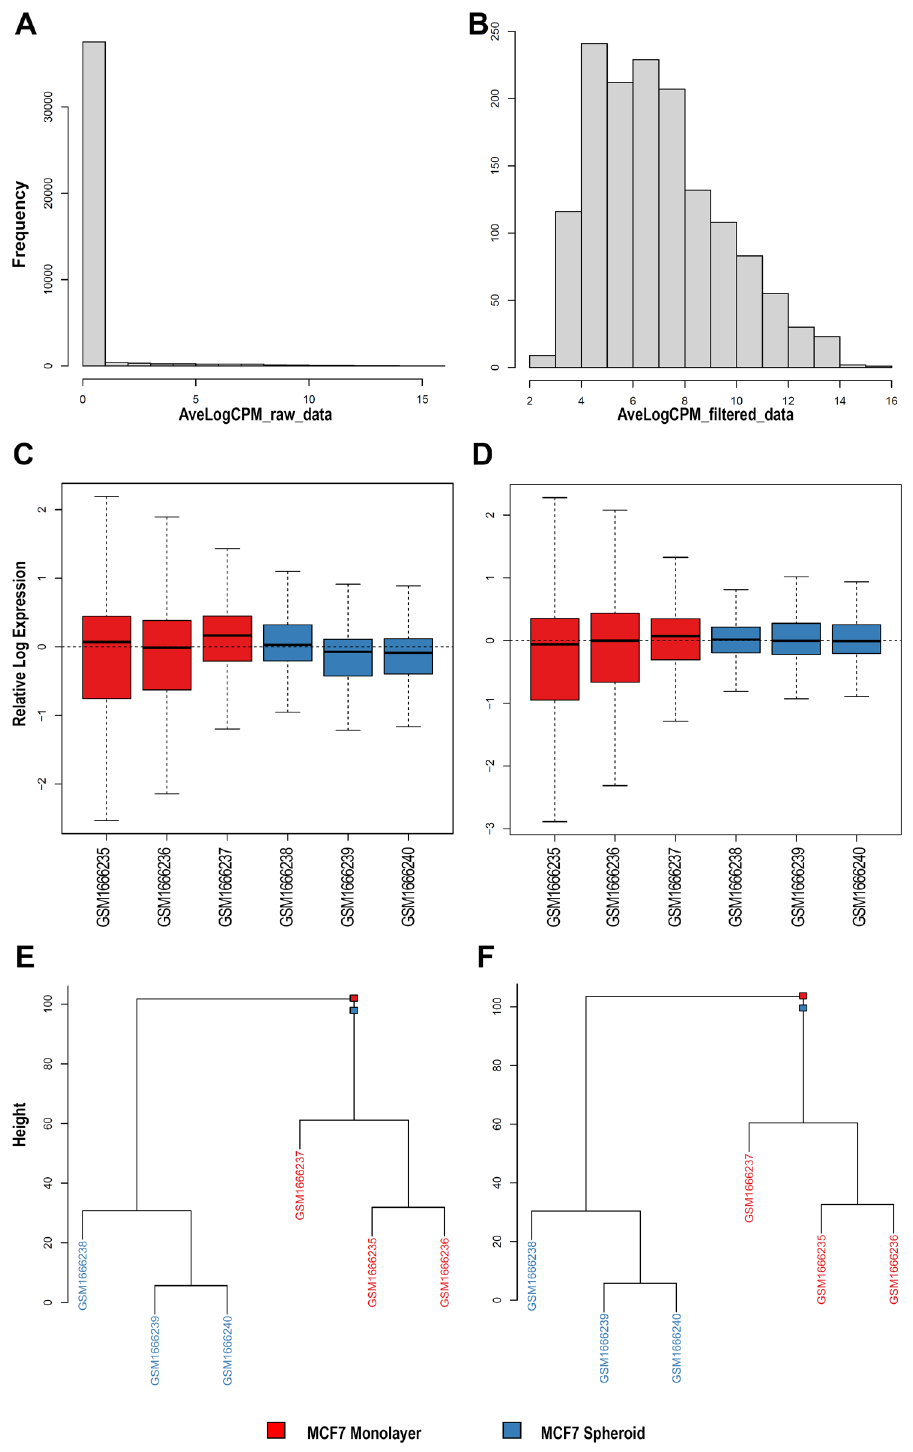
Figure 3. Exploratory data analysis plots generated by WIND. A – B ) Histograms of average log samples before ( A ) and after ( B ) filtering with one of the selected methods (EdgeR filtering in this case) for sncRNA data. C – D ) Relative Log Expression (RLE) plots for each normalisation method, made with the use of plotRLE function for all the sncRNA data. As an example, only the first two plots (with TMM ( D ) and without normalisation ( C ) for the filtered counts derived from FeatureCounts) are shown. E – F ) Hierarchical Clustering plots, exploiting all the sequenced sncRNA data, with multiple clustering methods and different normalisation methods. As an example, only the first two plots (with TMM ( D ) and without normalisation ( C ) for the filtered counts derived from FeatureCounts). In black and brown are shown the two different groups (monolayer and